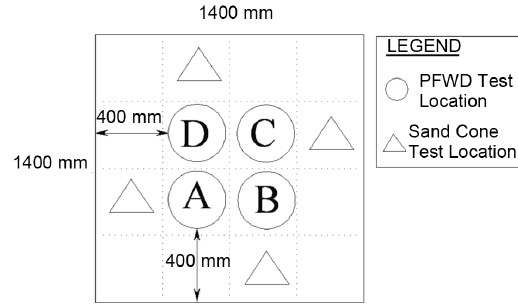
Fig. 4. Vertical displacements of dynamic loading versus the distances from loading plate center (FLAC output)